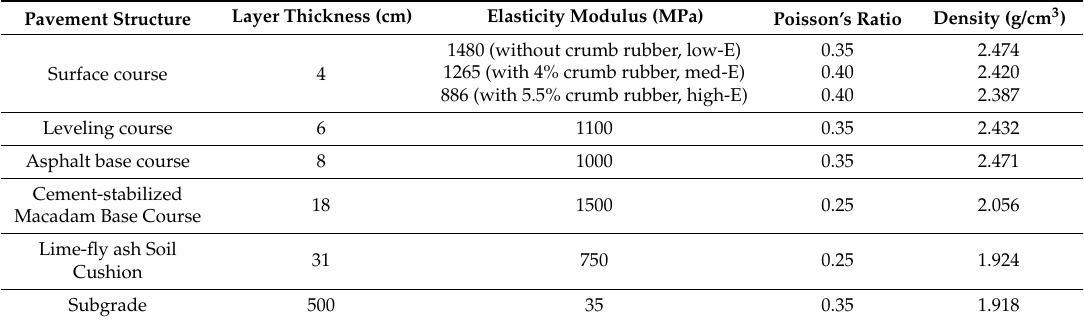
Table 3. Parameters of pavement structure